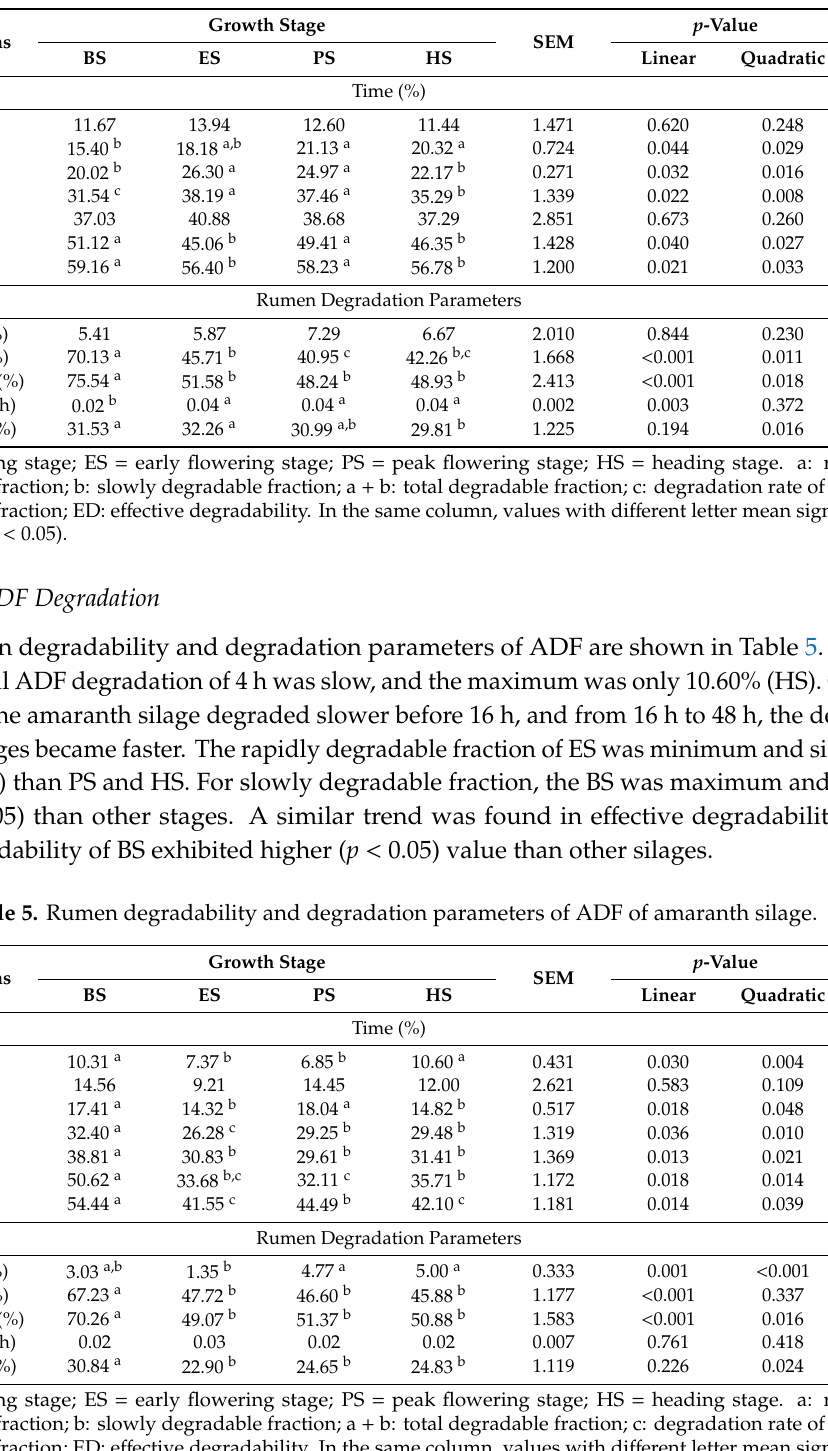
Table 4. Rumen degradability and degradation parameters of NDF of amaranth silage.